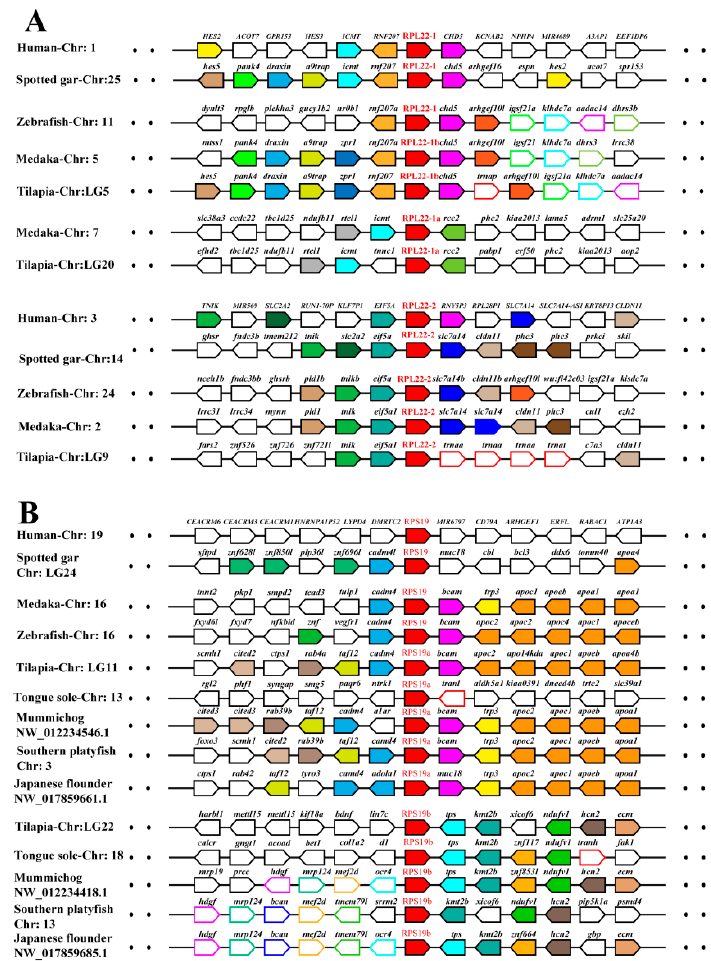
Figure 4. Synteny analyses of RPL22 ( A ) and RPS19 ( B ) and their adjacent genes in tilapia and other vertebrates. Rectangles represent genes in chromosome/scaffold. Dotted lines represent omitted genes of the chromosome/scaffold. The direction of the arrows indicates the gene orientation. The RP genes are shown in red, while the other genes are shown in different color.